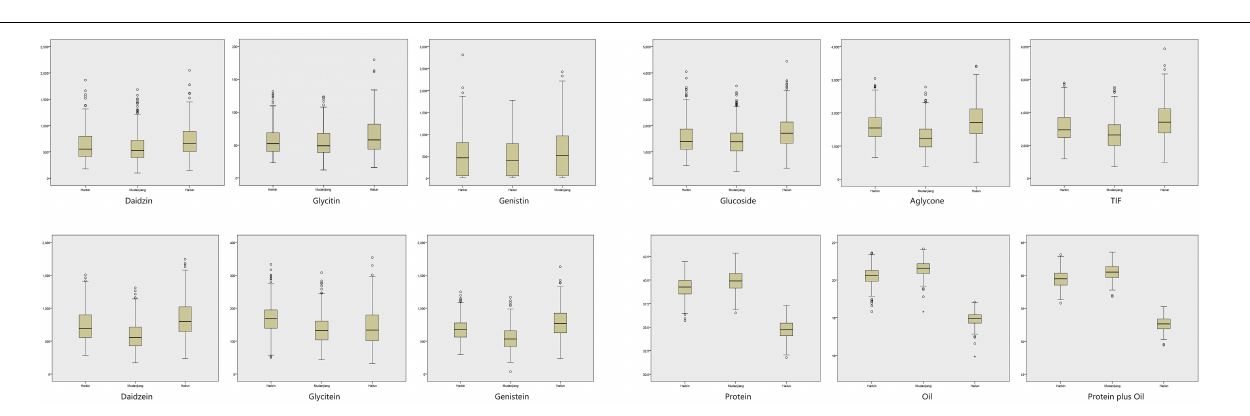
FIGURE 4 | The box plots of 12 quality traits contents in the three experimental locations (Harbin, Mudanjiang,